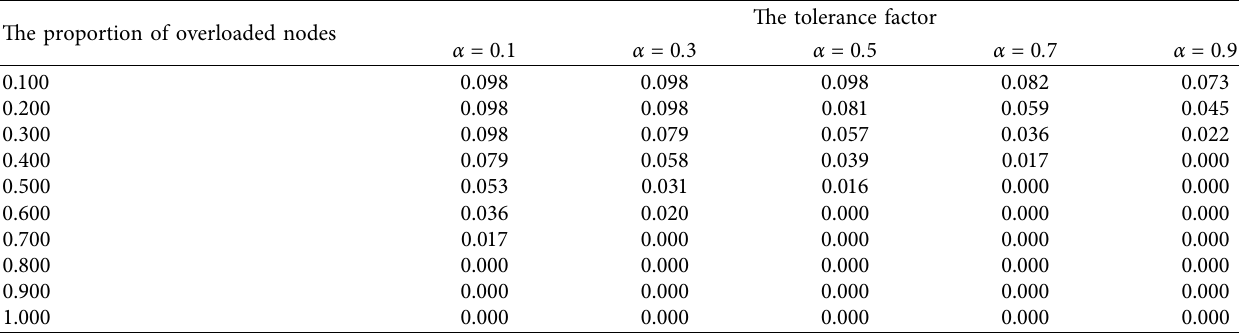
Table 13: Average network efficiency (d).